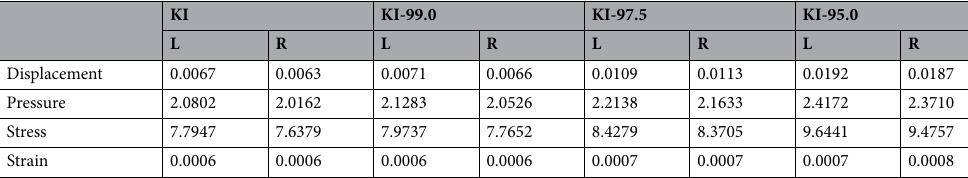
Table 3. Differences in biomechanical data from finite element (FE) models of the same specimens, but generated with 4 different segmentation methods. Mean displacement (mm), pressure (MPa), stress (MPa), and strain values of left (L) and right (R) femur datasets